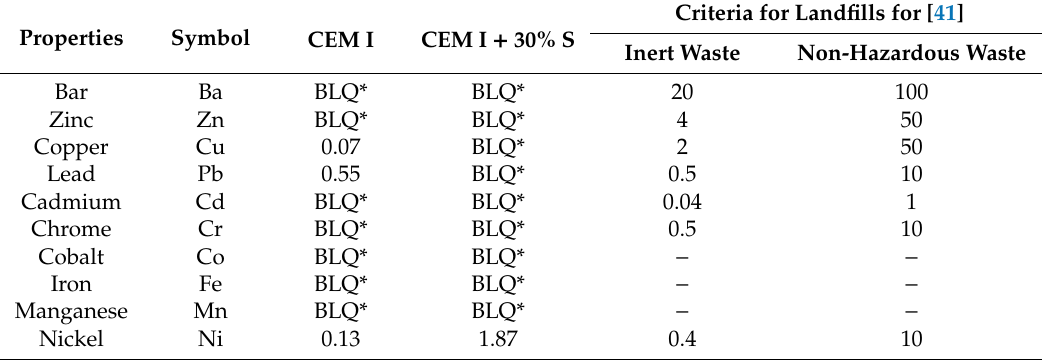
Table 14. Leachability of heavy metals from crushed mortar, expressed in mg /